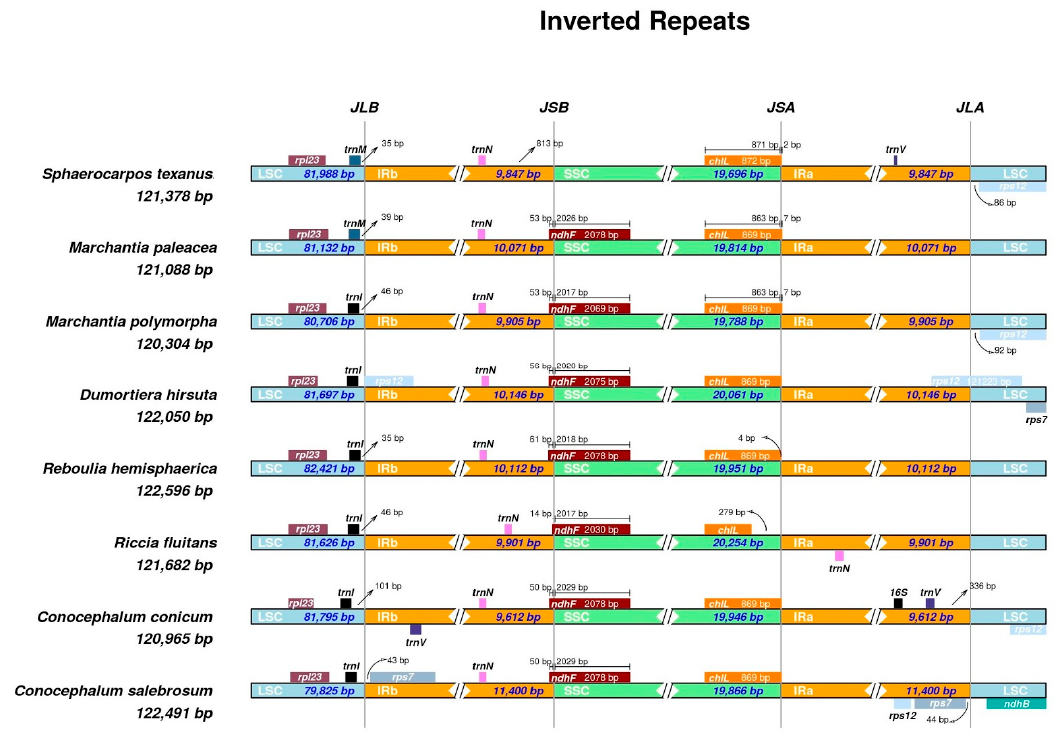
Figure 2. The di ff erences in inverted repeat (IR) borders among Figure 2. The differences in inverted repeat (IR) borders among Marchantiidae.